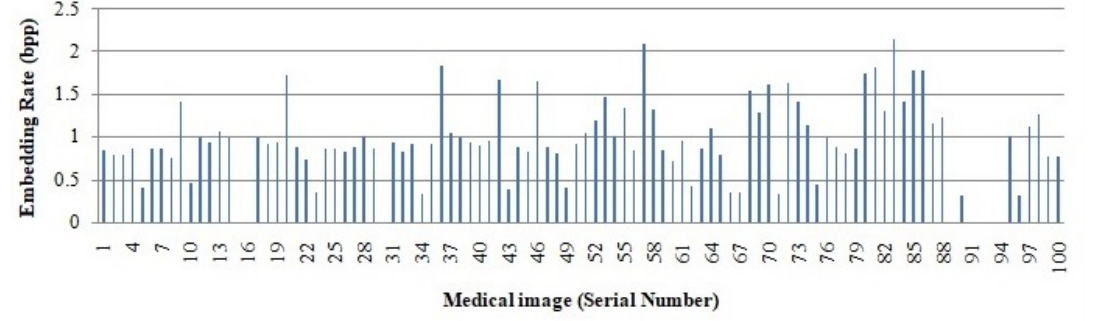
Figure 9. Embedding rate of 100 medical